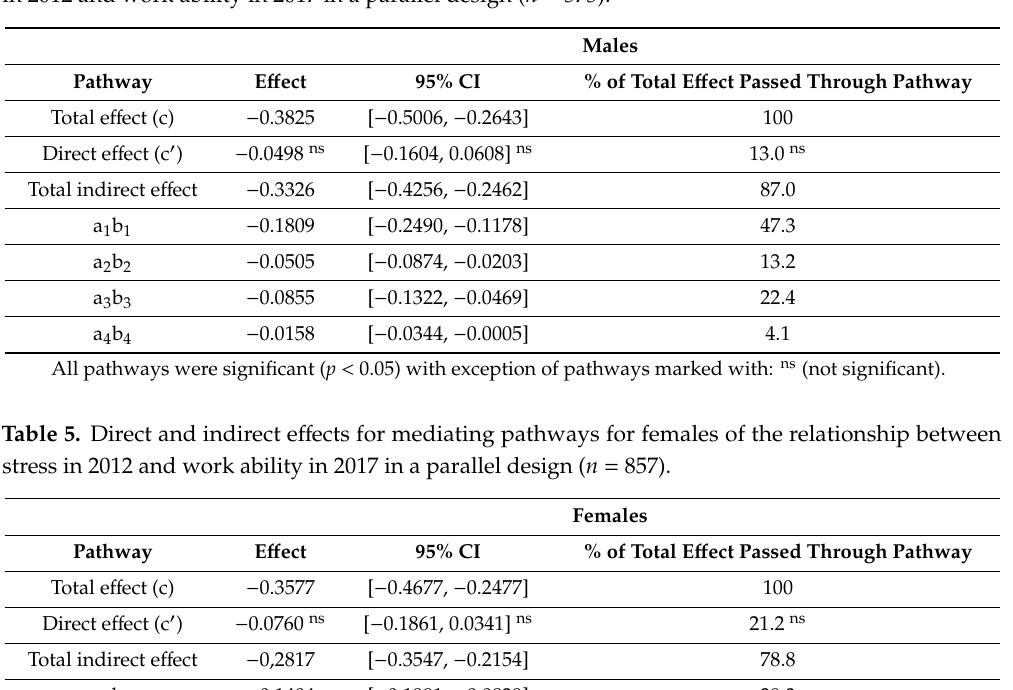
Table 4: Direct and indirect effects for mediating pathways for males of the relationship between stress in 2012 and work ability in 2017 in a parallel design ( n = 575).